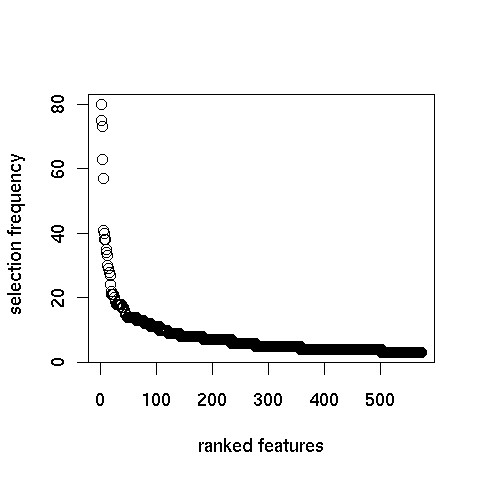
Selection frequencies. Ranked selection frequencies of the features which remained after the recursive feature elimination. The most selected feature was selected 80 times out of 100.